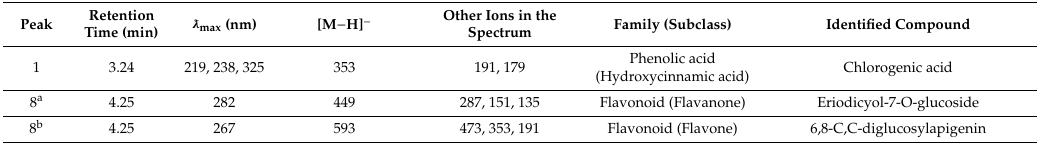
Table 5. Putatively peak identification of the major compounds detected by UHPLC-DAD in the CA extracts. λ max are the local maximum of absorbance on the UV spectrum. [M − H] − column provides the m / z value of the precursor ion. Other ions column gives the m / z value of the fragments that were detected in the MS spectra. Identification method using UV and ESI (-) spectra. Lot number: 559980. Peak